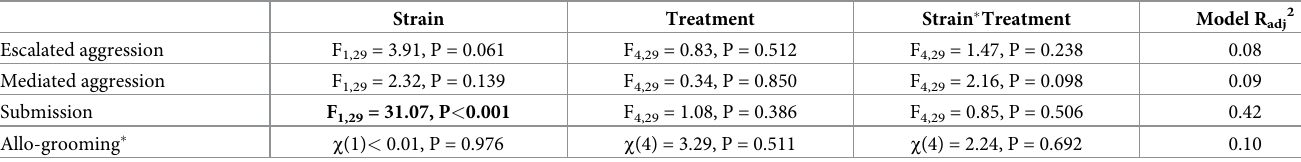
Table 5. Fixed effects and model R adj2 for each behavior measured after cage change (N =